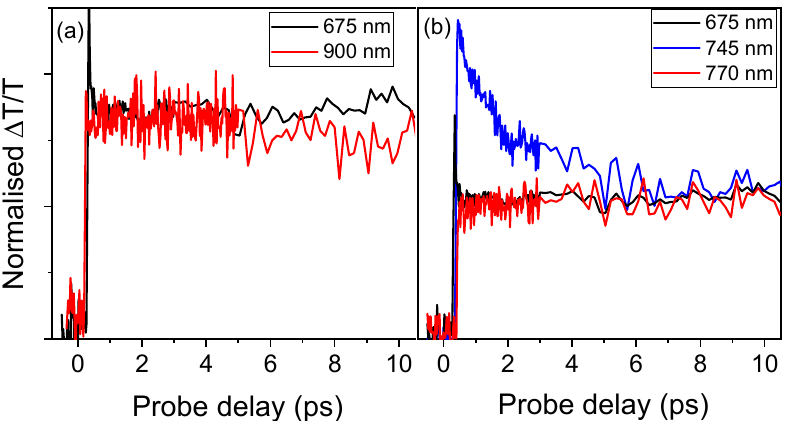
Figure 7. ( a ) Dynamics at different probe wavelengths: 675 nm (black line) and 900 nm (red line). ( b ) Dynamics at different probe wavelengths: 675 nm (black line), 745 nm (blue line), and 770 nm (red line).